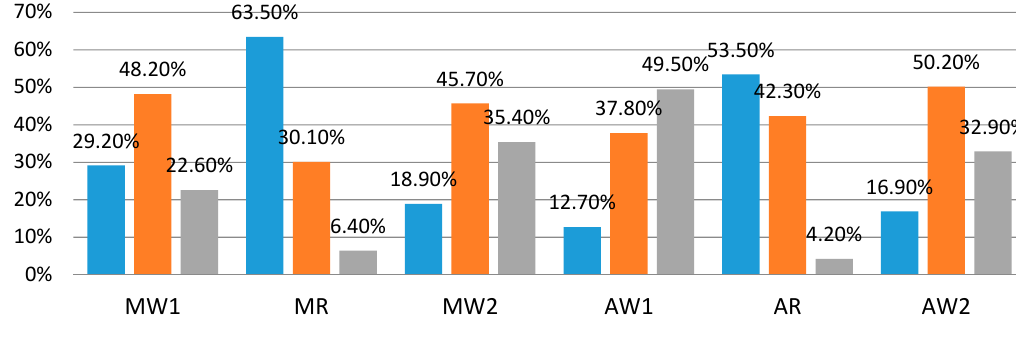
Figure 4. Distribution frequency of metabolic stress in different periods.